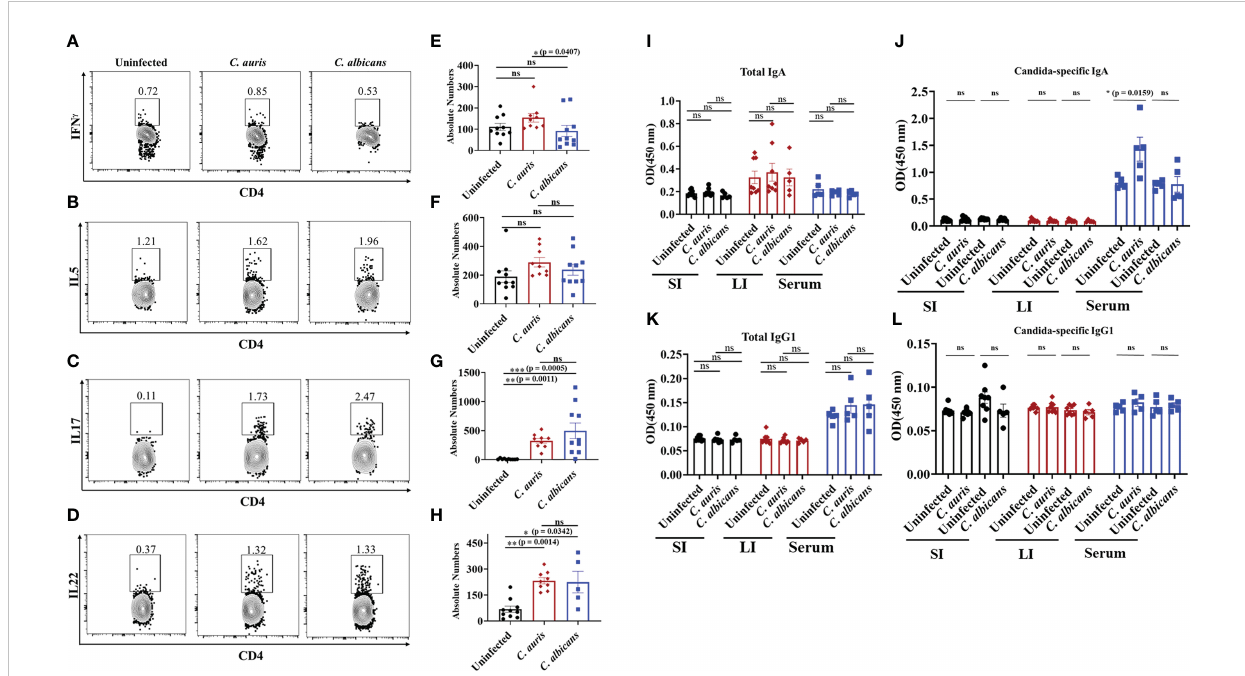
FIGURE 4 Adaptive immune response in the intestine of C. auris and C. albicans infected mice groups. Mice treated with cefoperazone for 7 days and infected with C. auris 0387 (or) C. albicans SC5314. Antibiotic treatment was continued till the end of experiment and groups of uninfected mice were used as control. After 10-12 days of infection, mice were euthanized to isolate and stain monocular cells from large intestine. Gut contents and serum were collected to assess the total and Candida-speci fi c IgA and IgG level in C. auris -infected, C. albicans -infected and uninfected mice Representative fl ow plots and the absolute number of CD4+ IFN g + T helper cells (A, E) , CD4+ IL5+ T helper cells (B, F), CD4+ IL17+ T helper cells (C, G) and CD4+ IL22+ T helper cells (D, H) from the large intestine of uninfected, C. auris infected and C. albicans infected are shown. Total IgA (I) and Candida -speci fi c IgA (J) levels in the small intestine (SI), large intestine (LI) and serum from uninfected, C. auris and C. albicans infected mice were shown. Total IgG1 (K) and Candida - speci fi c IgG1 (L) levels in the small intestine (SI), large intestine (LI) and serum from uninfected, C. auris and C. albicans infected mice were shown. For immune cell analysis, all groups had 8-10 mice, except for C. albicans infected mice for IL22+ immune cell analysis had 5 mice. For IgA and IgG1 determination, each group had 5-8 mice. Data represent mean ± SEM. For immune cells, statistical signi fi cance was calculated using the Kruskal-Wallis test followed by Dunn ’ s multiple comparison test. For IgA and IgG1 analysis, statistical signi fi cance was calculated using Mann-Whitney U test, with ns indicates non-signi fi cant and * p ≤ 0.05, ** p ≤ 0.01 *** p ≤ 0.001 were considered signi fi